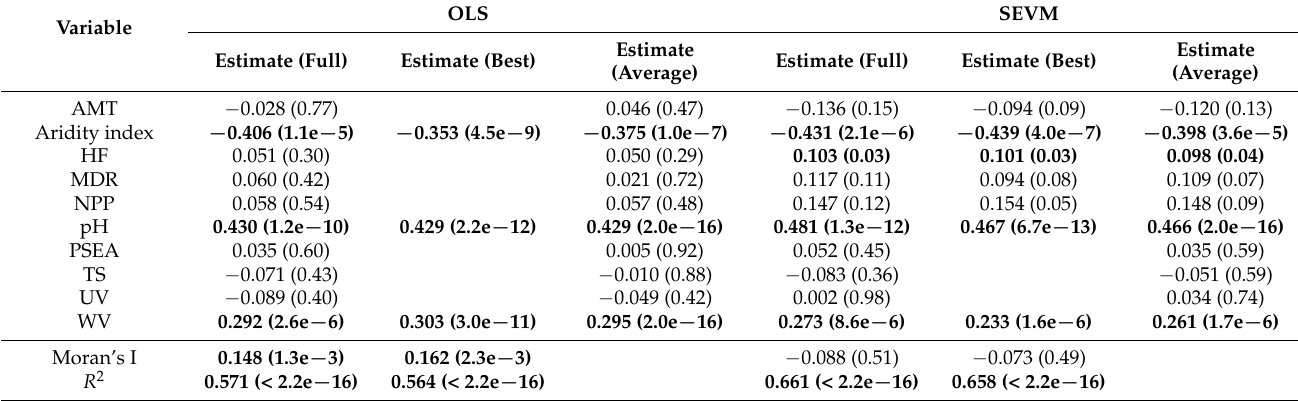
AMT, annual mean temperature; MDR, mean diurnal temperature range; TS, temperature seasonality; PSEA, precipitation seasonality; NPP, normalized difference vegetation index; UV, UV radiation index; HF, human footprint score; and WV, warming velocity. The estimates in the full, best, and averaged models based on the ordinary least squared (OLS) regression and spatial eigenvector mapping (SEVM) modeling approach correspond to the standardized partial regression coefficients in the models. R 2 corresponds to the coefficient of determination. Values in brackets are the associated p -values. Bold values denote statistical